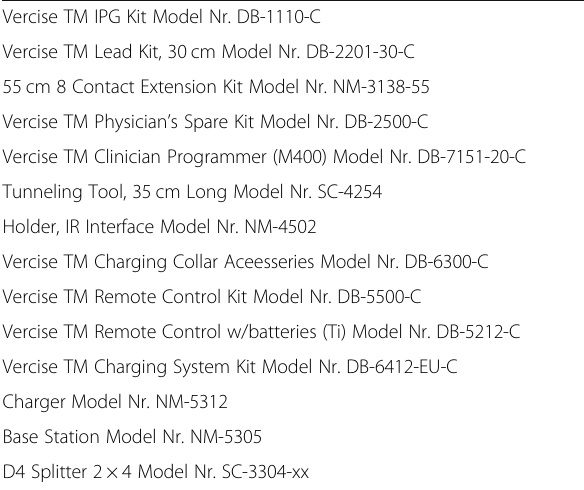
Table 3 Details of the vercise ™ neuromodulation system (Boston Scientific Corporation